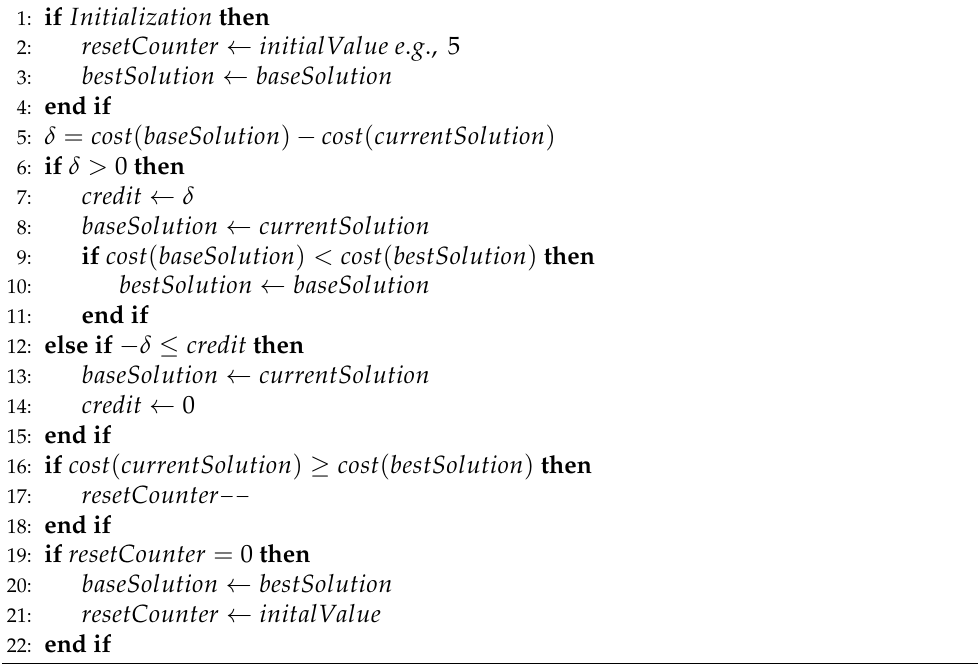
Algorithm 2 Reactive biased-randomization of triangular distribution